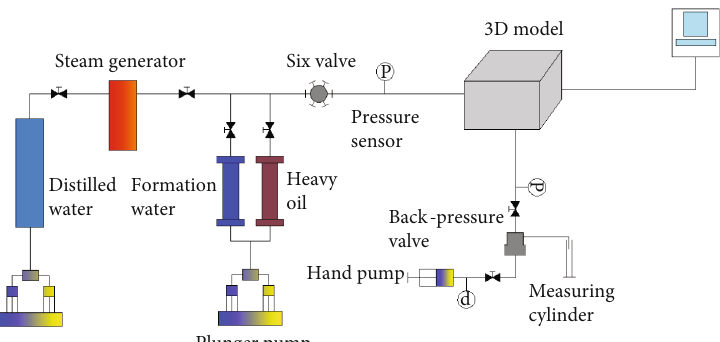
Figure 10: Flow diagram of 3D physical